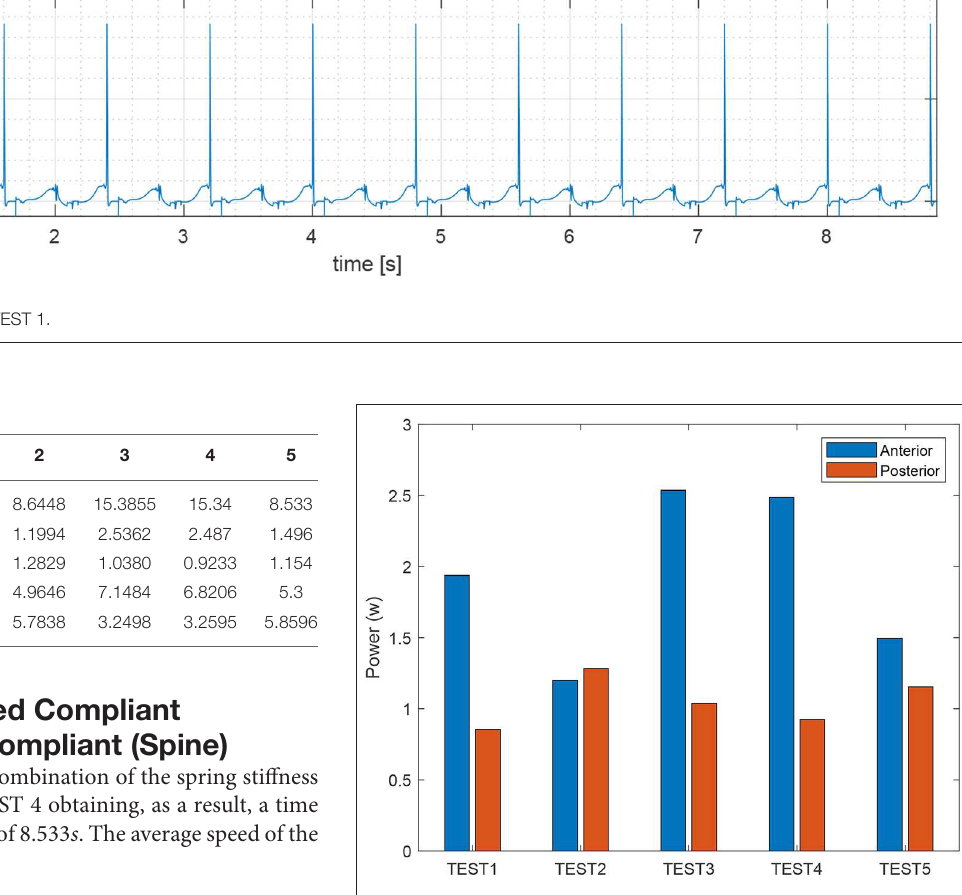
FIGURE 12 | Requested power for each